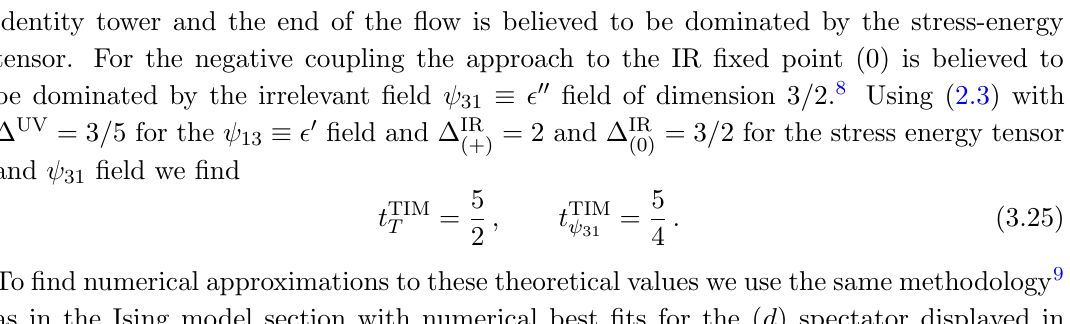
identity tower and the end of the (cid:13)ow is believed to be dominated by the stress-energy tensor. For the negative coupling the approach to the IR (cid:12)xed point (0) is believed to be dominated by the irrelevant